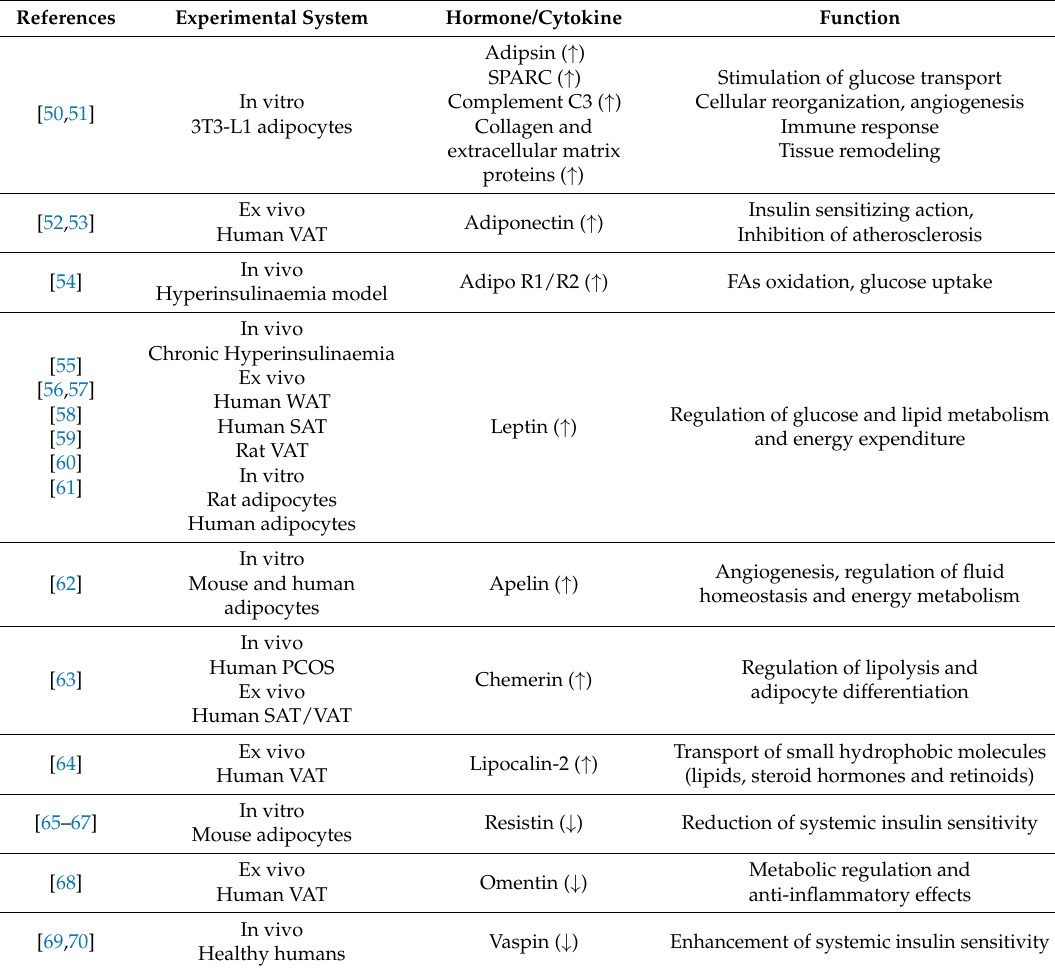
Table 1. Insulin effects on adipose tissue (AT) endocrine